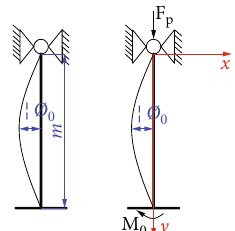
Figure 6: Mechanical model of the solid coal side of the retraction channel.